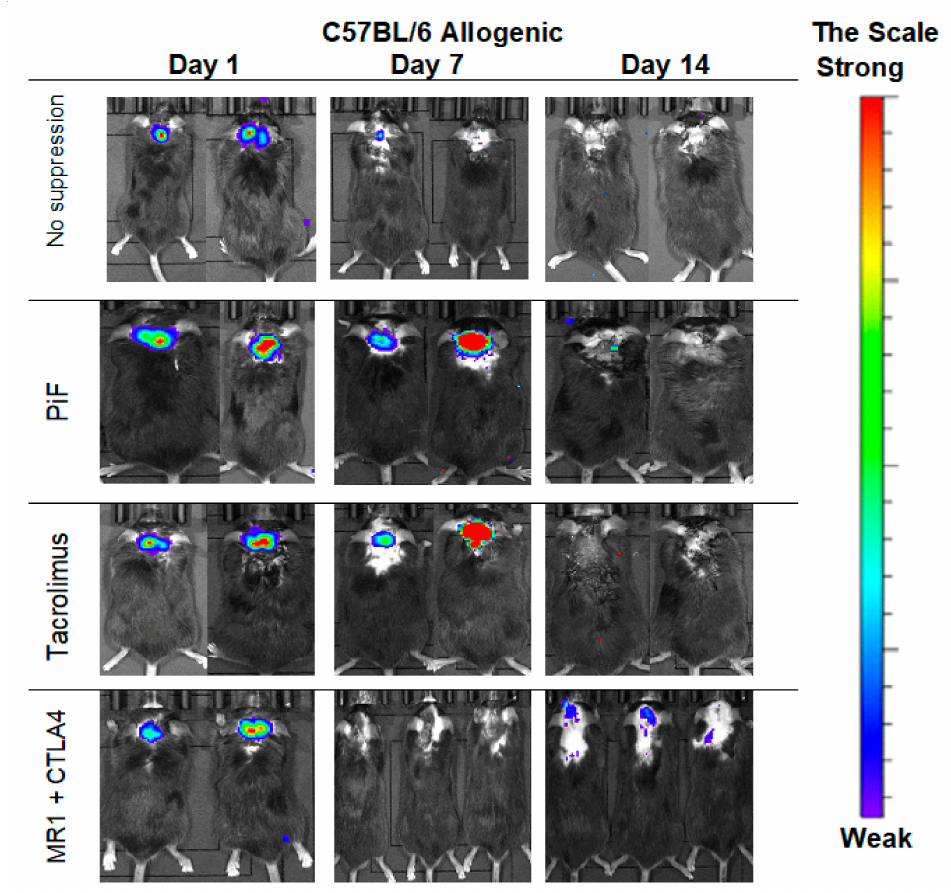
Figure 6. Representative pictures illustrating the murine GRP graft survival after transplantation into an allogeneic C57BL/6 mouse model: The BLI signal vanished quickly at the day 7 in immunosuppression-free and was weak at the co-stimulatory blockade group; surprisingly, however, the strongest signal intensity on day 14 was revealed again in the co-stimulatory blockade group. Abbreviations: BLI-bioluminescence imaging; GRP-glial-restricted progenitor